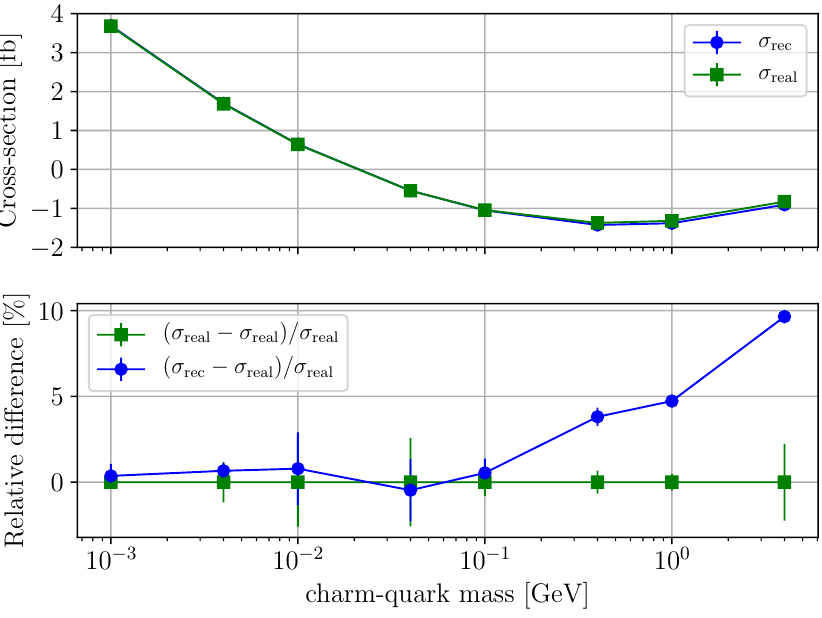
Figure 4 . The cross section of the gg → Hc ¯ c process calculated by a direct integration of the matrix element with non-zero charm-quark mass, σ real (green rectangles), and reconstructed using procedure described in previous subsections, σ rec (blue circles). We employ the same parameters and kinematic constraints as in the main